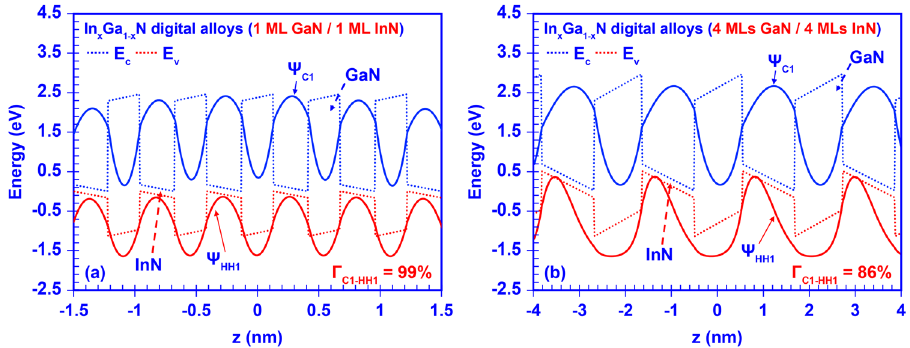
Figure 6. Wave functions of ground state carriers in 50-periods InGaN digital alloy formed by: ( a ) 1 ML GaN and 1 ML InN binary layers, ( b ) 4 MLs GaN and 4 MLs InN binary layers.